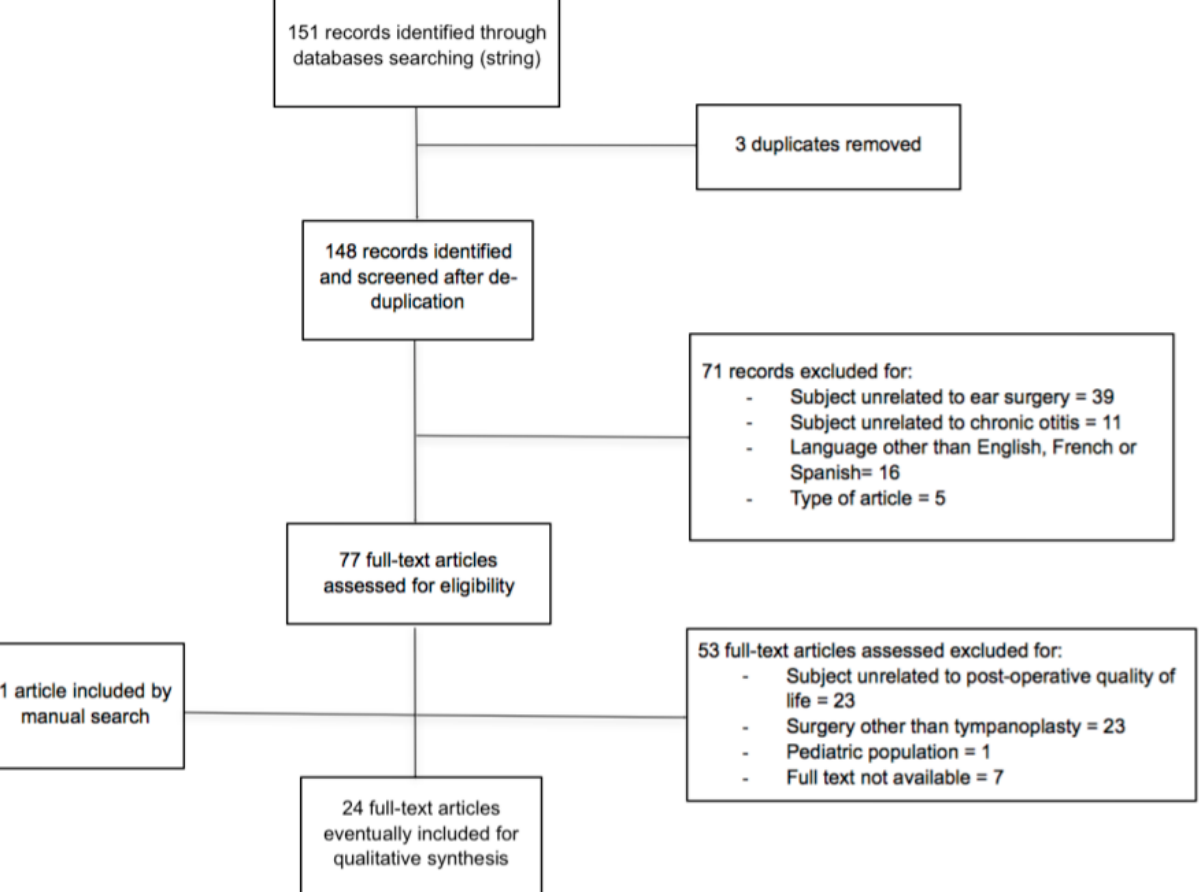
Figure 1. Flow chart for study selection.